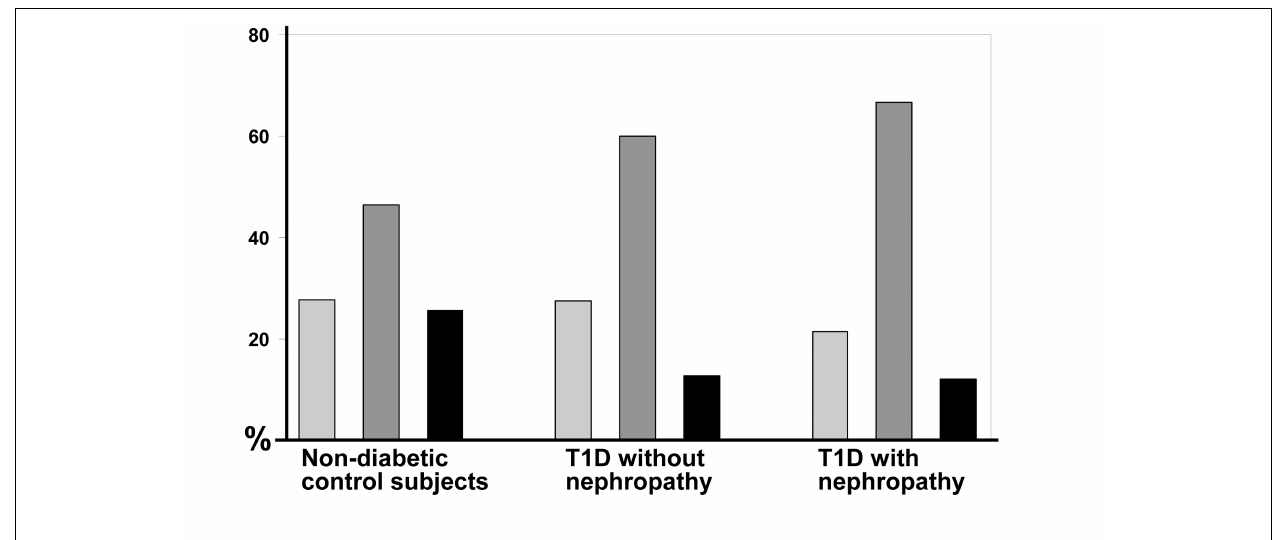
and dark for E469E. Obviously, the heterozygous index is high compared to the percentage of homozygous and increased from the group of non-diabetic control subjects, to type 1 diabetes (T1D) patients without diabetic nephropathy and the patients with diabetic